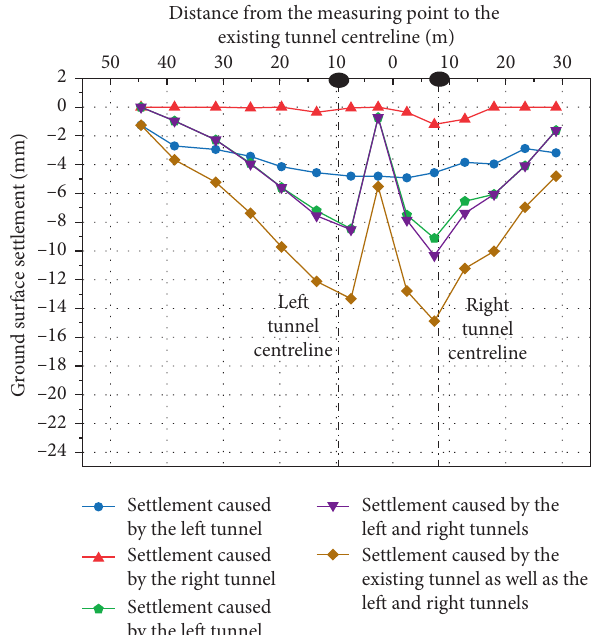
Figure 8: Ground surface settlement caused by construction.